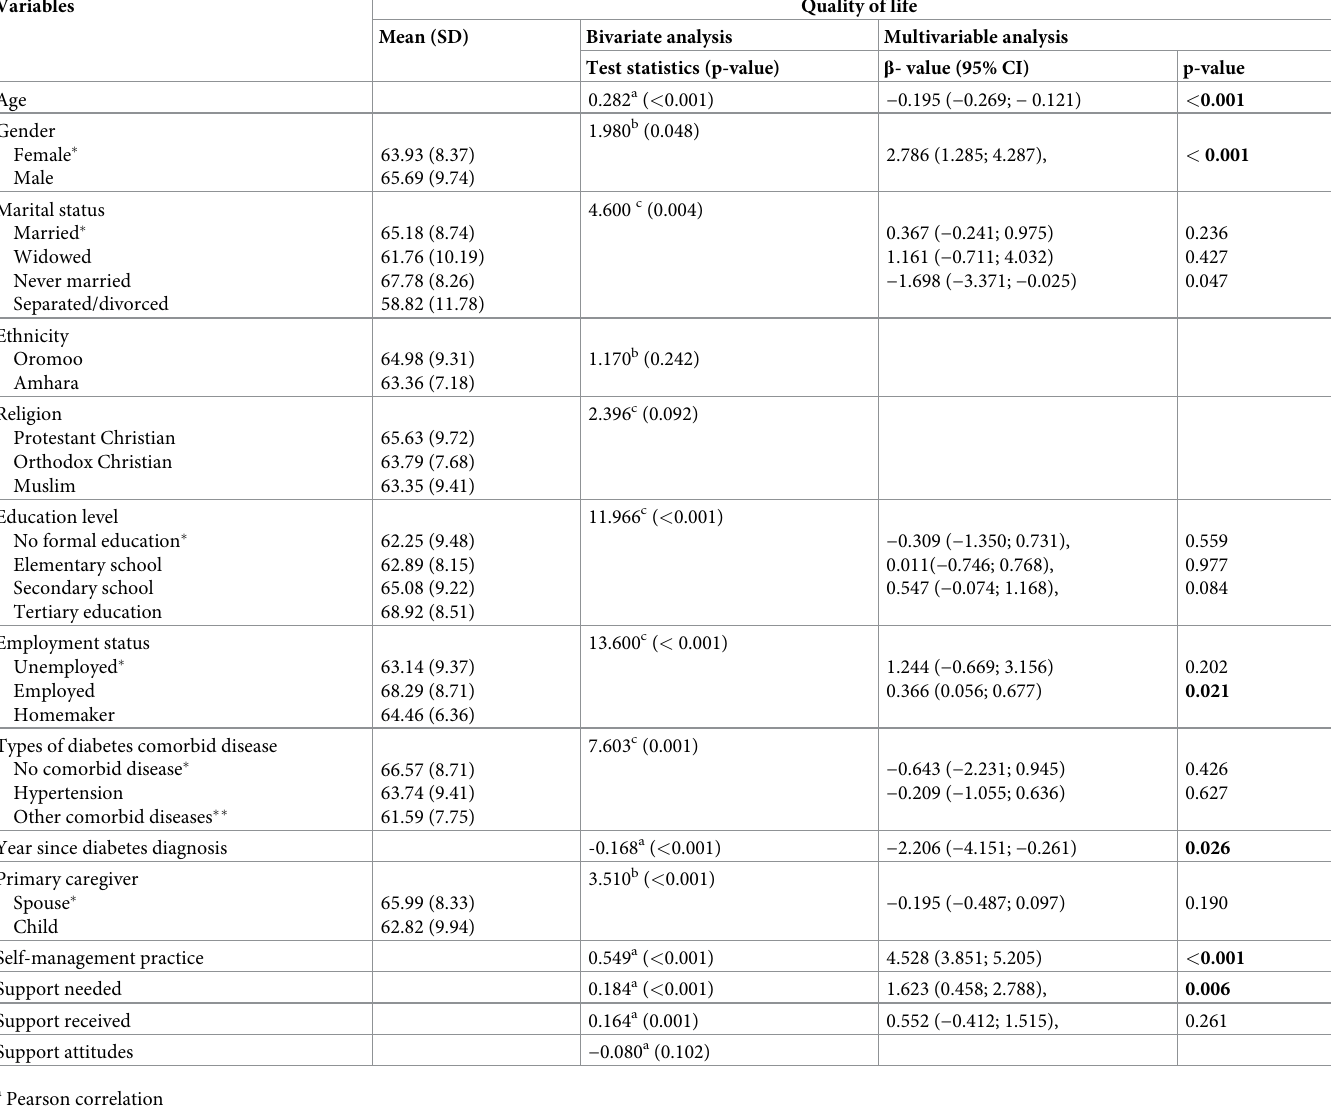
Table 2. Bivariate and multivariable analyses of variables with overall quality of